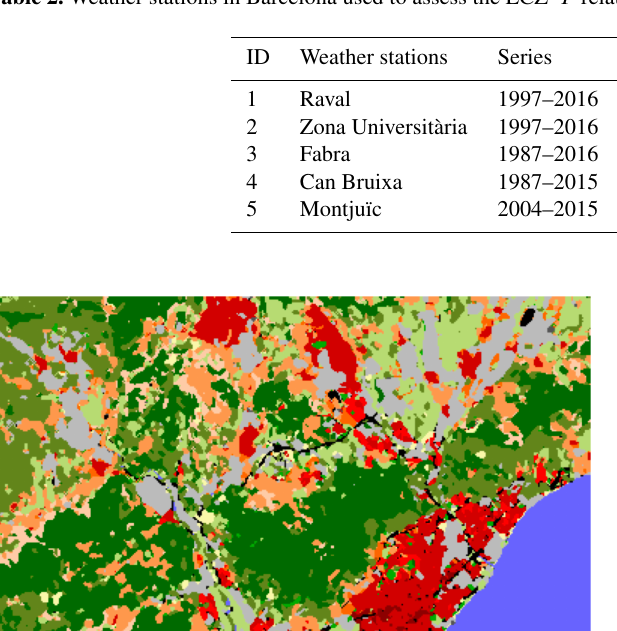
Figure 4. Workflow used to obtain the LCZ LCLU model. Table 2. Weather stations in Barcelona used to assess the LCZ– T relationship based on daily mean temperatures.